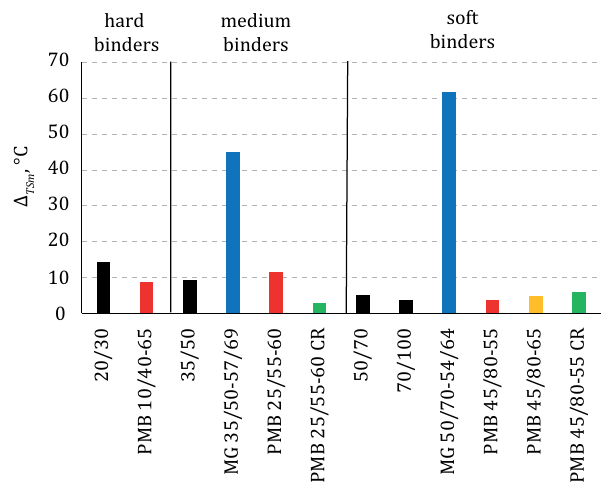
Figure 8. Differences between limiting temperatures obtained from stiffness modulus and m -value